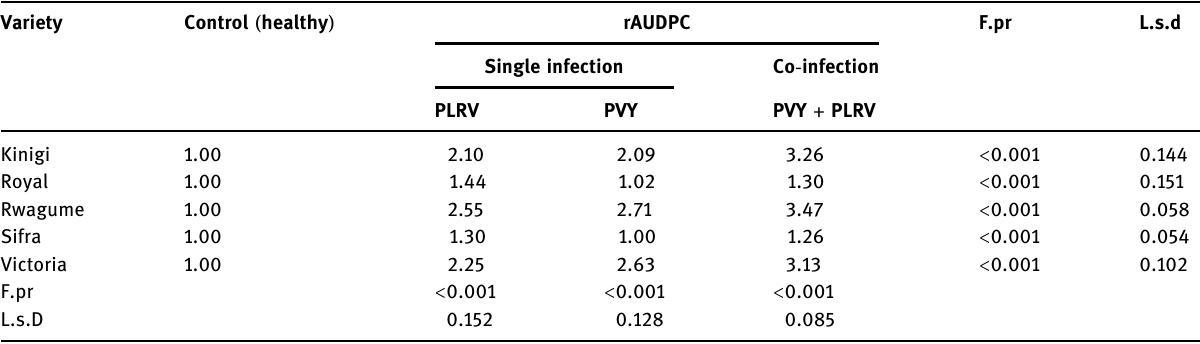
Table 2: Relative area under disease progress curve ( rAUDPC ) as a measure of disease severity for PVY, PLRV and combination on fi ve potato varieties